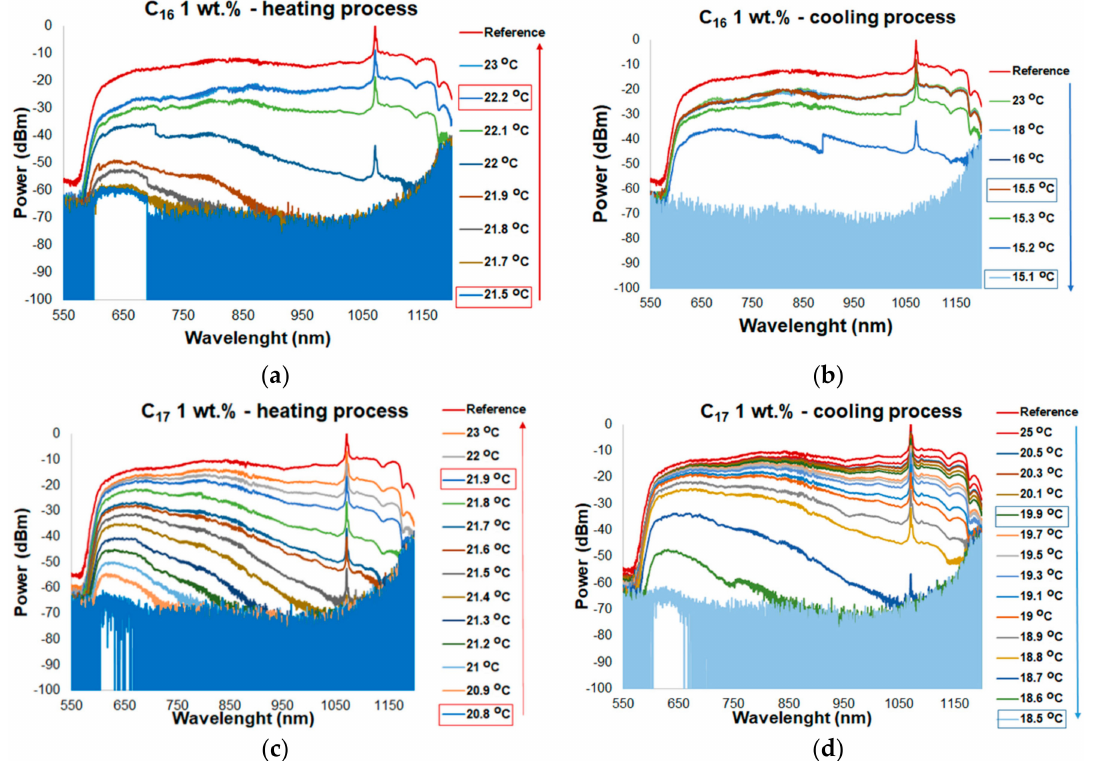
Figure 7. Transmission of a tapered optical fiber in the range of wavelengths of 550–1200 nm for di ff erent temperatures for: ( a ) heating process for C 16 + 1 wt.% ZnS:Mn nanoparticles (NPs), ( b ) cooling process for pure C 16 + 1 wt.% ZnS:Mn NPs, ( c ) heating process for pure C 17 + 1 wt.% ZnS:Mn NPs, and ( d ) cooling process for pure C 17 + 1 wt.% ZnS:Mn